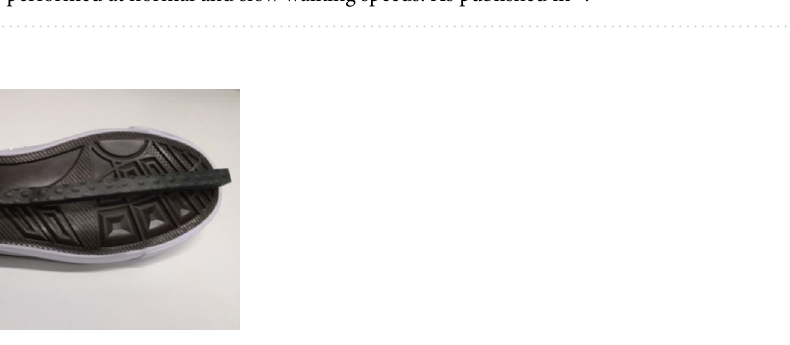
Table 1. Conditions performed at normal and slow walking speeds. As published in 12 .